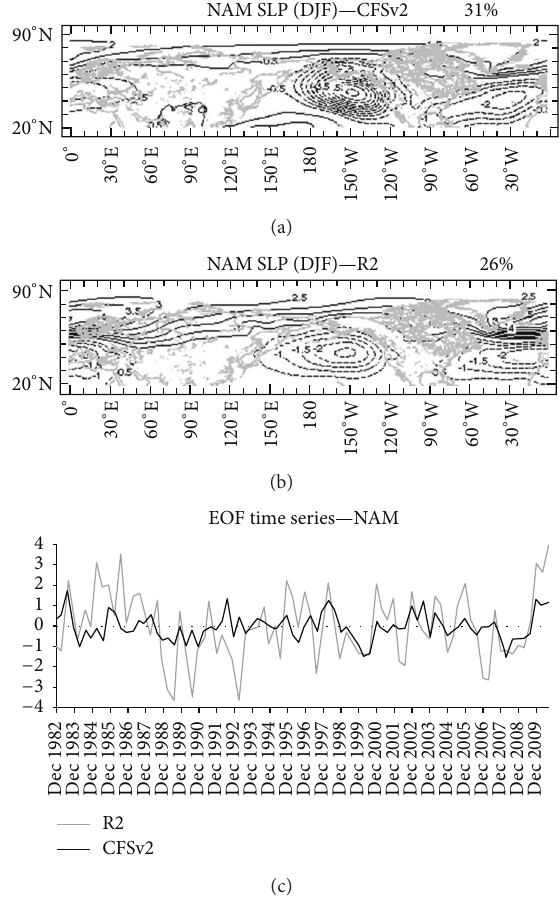
Figure 11: Northern Annular Mode (NAM) captured from SLP anomalies over 20 ∘ –90 ∘ N during DJF season at 0-month lead for (a) CFSv2; (b) R2 data; (c) the corresponding EOF time series which gray (black) line is related to R2 (CFSv2). Contour interval is 1hPa from 0.5 hPa and negative contours are dotted. (a) and (b) are adapted from IRI/LDEO Climate Data